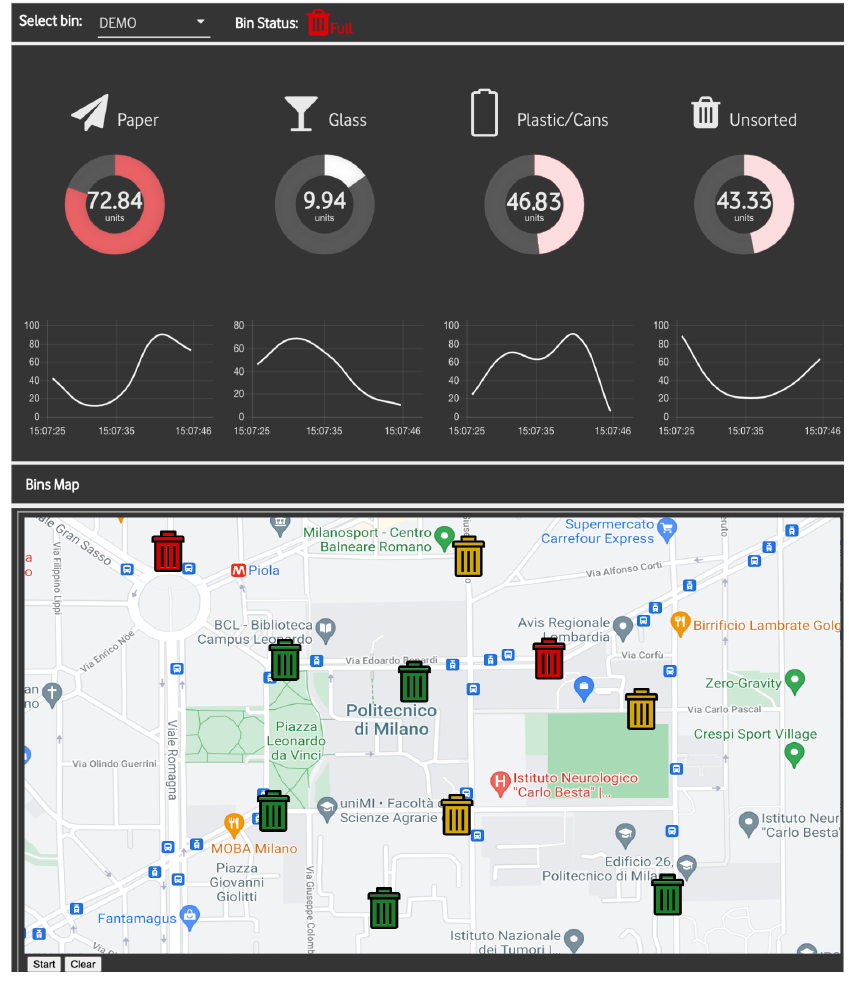
Figure 13. Smart waste bin backend dashboard implemented with Node-RED. The map shows the bins’ position as well as a graphical summary of the fill levels. Respectively, red when at least one class is greater than 70%; yellow when at least one class is greater than 40% and green when all the classes are below or equal